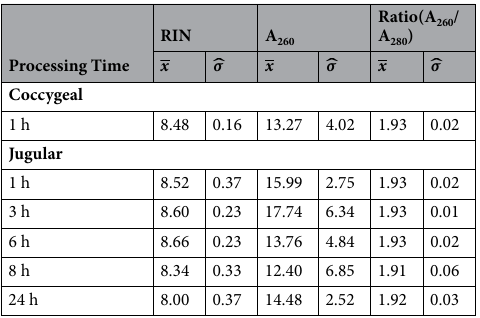
Table 1. RNA parameters obtained from peripheral white blood cells. x : average; (cid:31) σ : standard deviation.